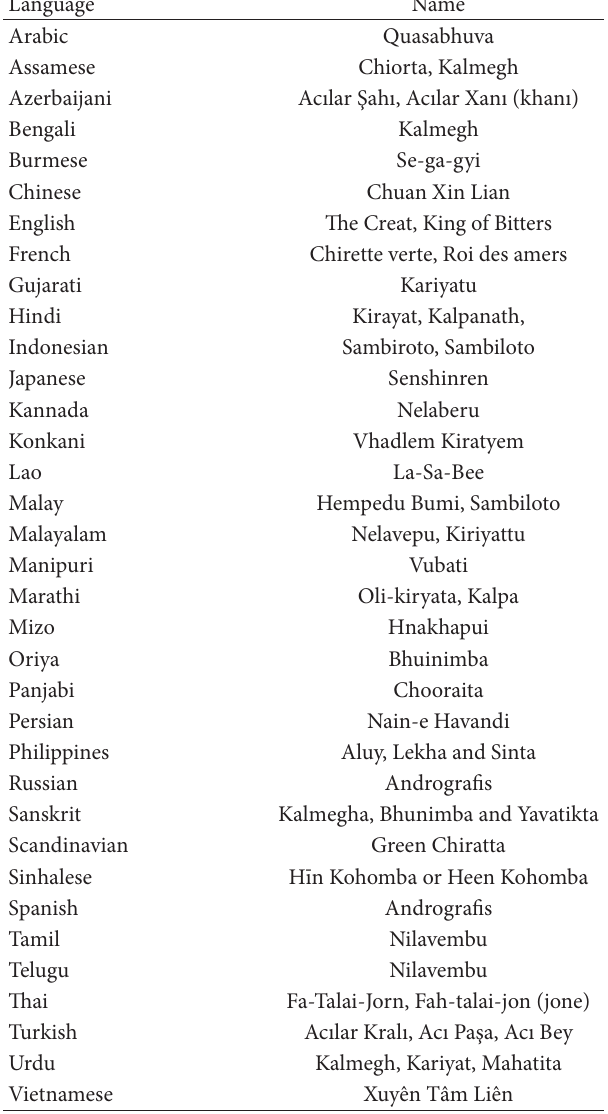
Table 2: The vernacular names of A. paniculata [10, 71, 75,